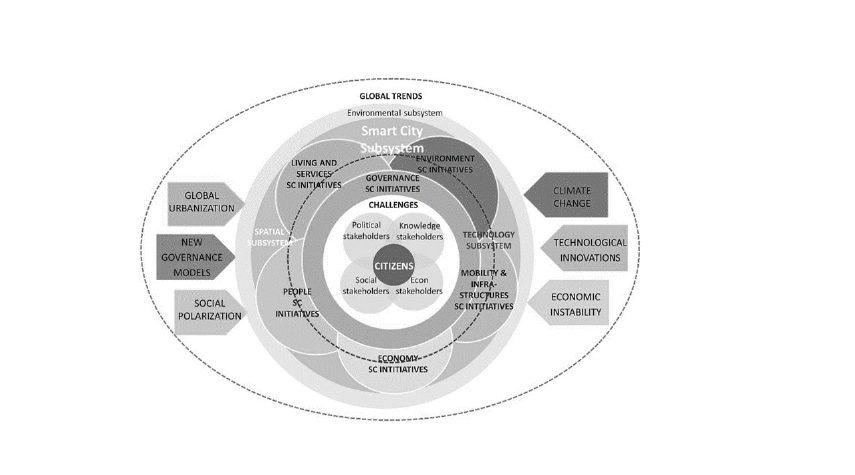
Figure 2. Smart city implementation and discourses: An integrated conceptual mode